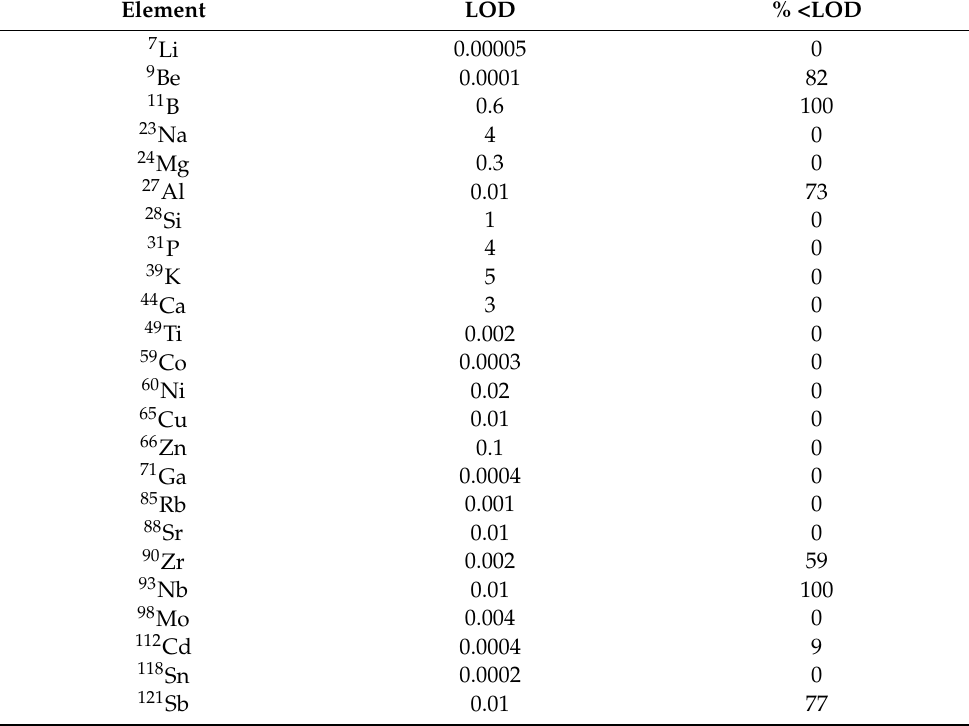
Table 1. Selection of isotopes, limit of determination (LOD) expressed as µ g g − 1 formula and percentage of values lower than LOD for each